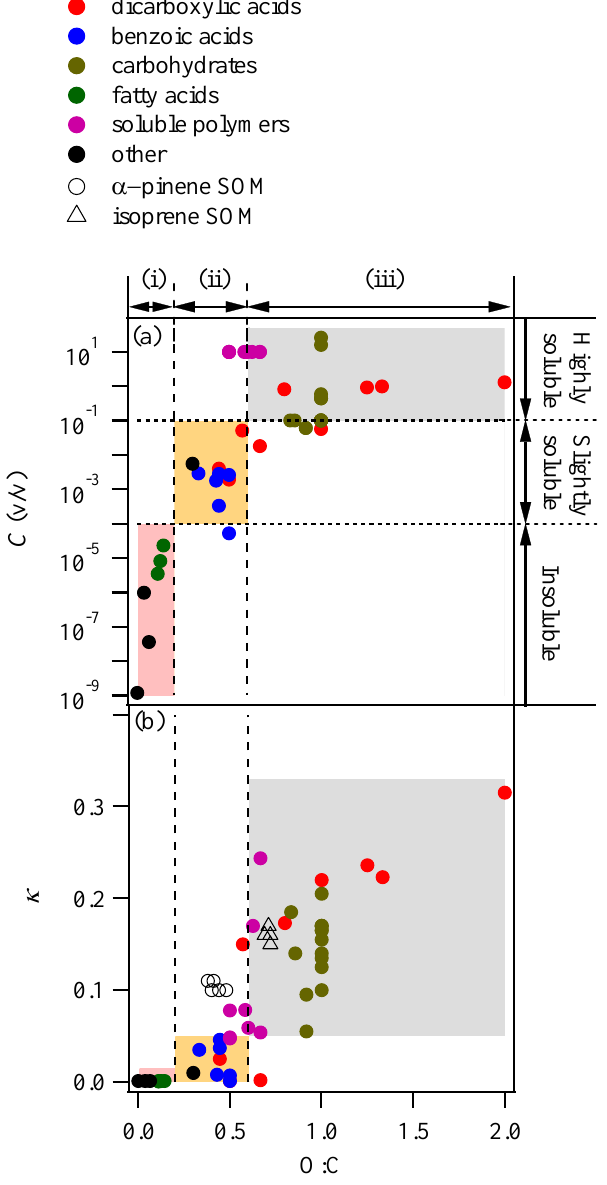
Fig. 3. Relationship of O:C ratio to (a) C and (b) κ . The colored areas in the panels highlight clustering among insoluble, slightly soluble, and highly soluble compounds. Compounds are listed in the Supplement.